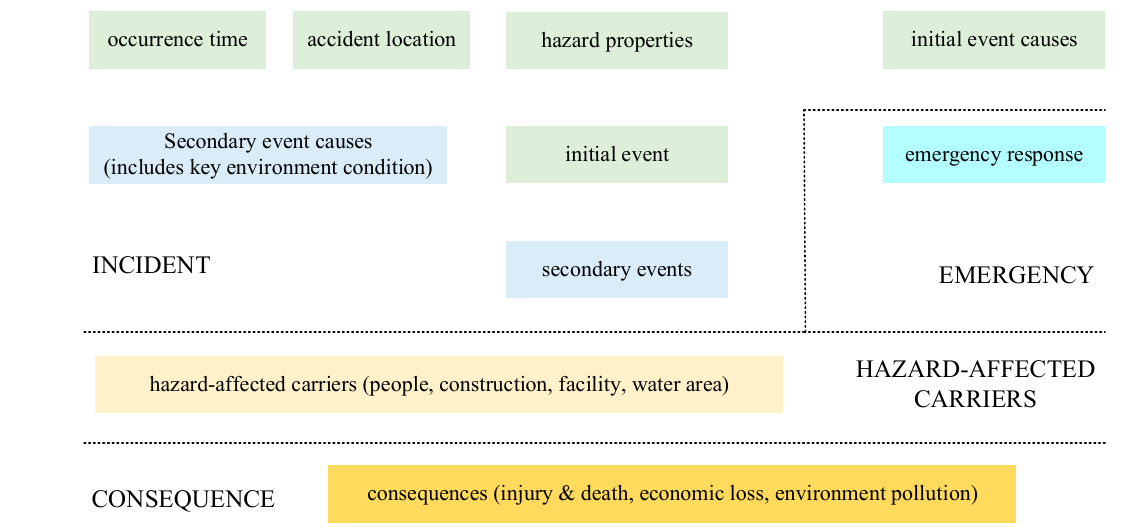
Figure 3. The BN node deployment rules for an oil pipeline accident.